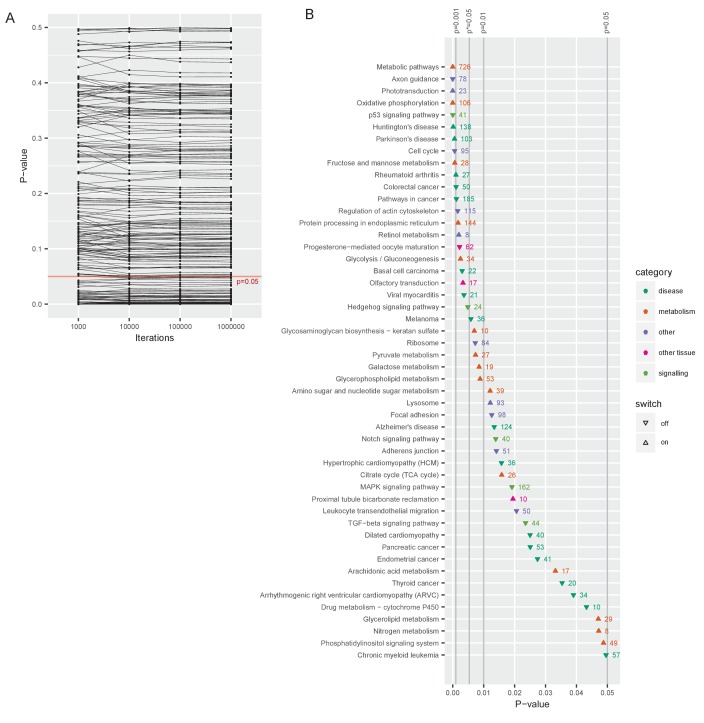
Gene classes and pathways involved in the switch.(A) Changes in p-value as the number of random draws (iterations) in the permutation analyses increases. Each dot represents one pathway. (B) All significantly up- or downregulated pathways are ordered by p-value (at 1 million iterations), and color-coded by category, p* is the p-value adjusted by the Benjamini and Hochberg method (Benjamini and Hochberg, 1995).